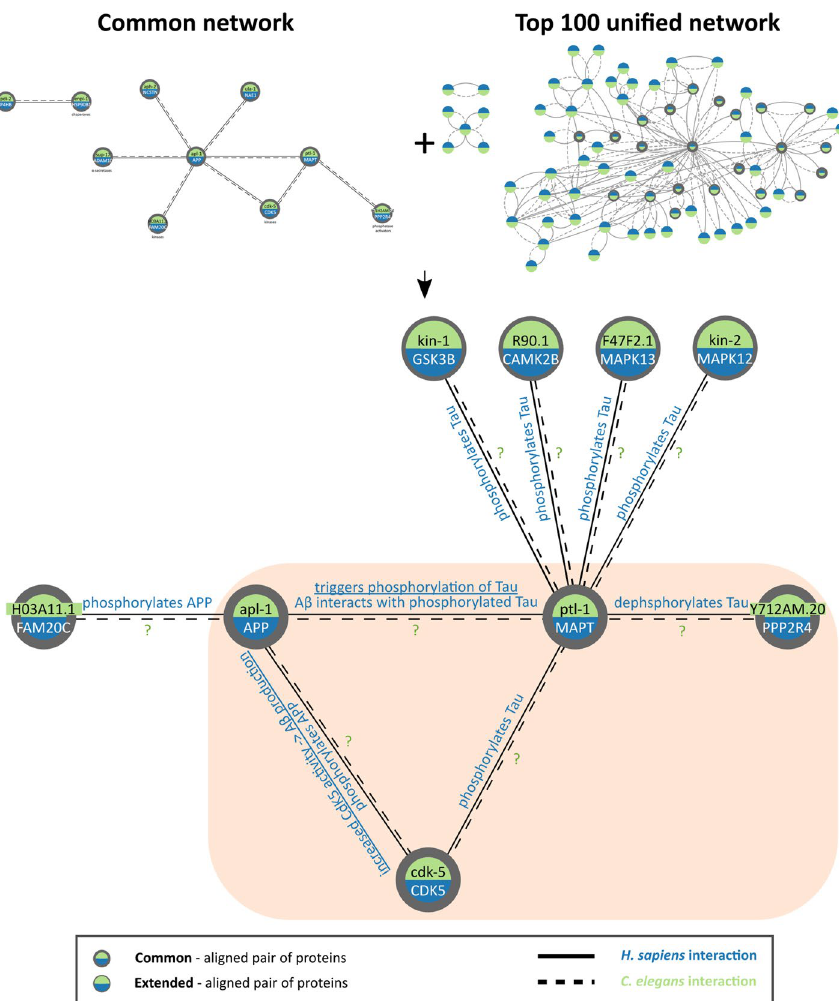
Figure 4. AD associated phosphorylation-related proteins conserved in H. sapiens and C. elegans . Shown here are elements related to phosphorylation of APP and Tau found in the Common Network , extended with relevant proteins and interactions from the “ Top 100 interaction partners ” dataset. The interactions appear to be conserved in both organisms, but no information was available for the C. elegans interactions. The gene symbol for Tau is